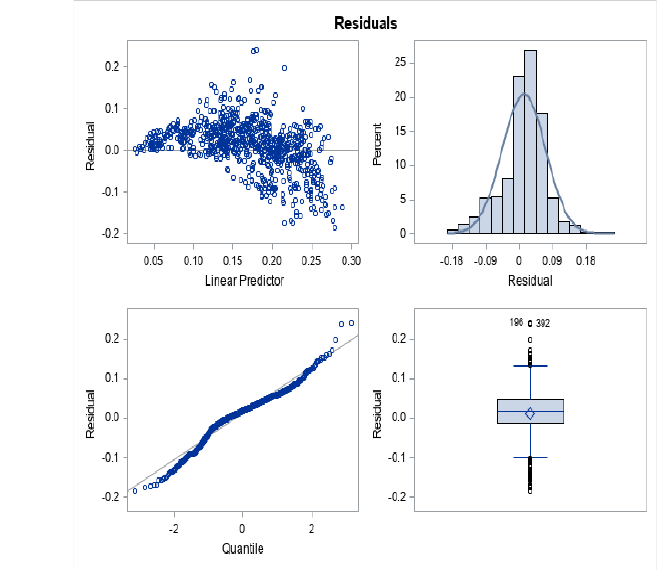
Figure 4. Conditional and marginal residual plots for a general linear mixed model.